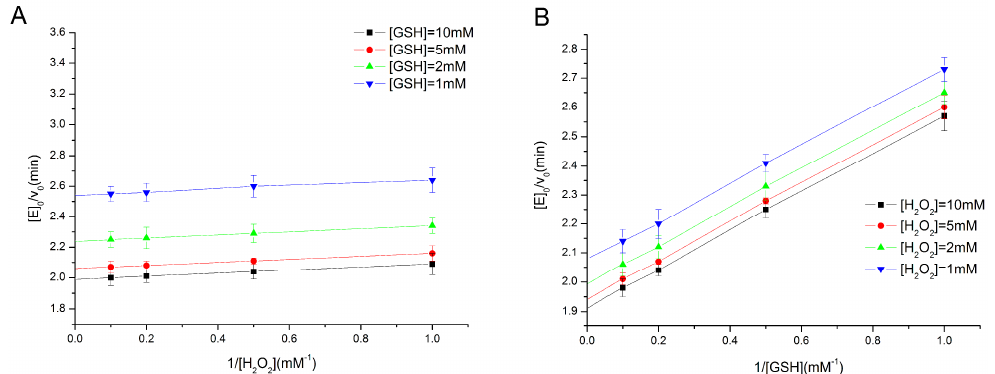
Figure 1. Double ‐ reciprocal plots for the reduction of H 2 O 2 catalyzed by 6 ‐ TediCD in the GSH system.